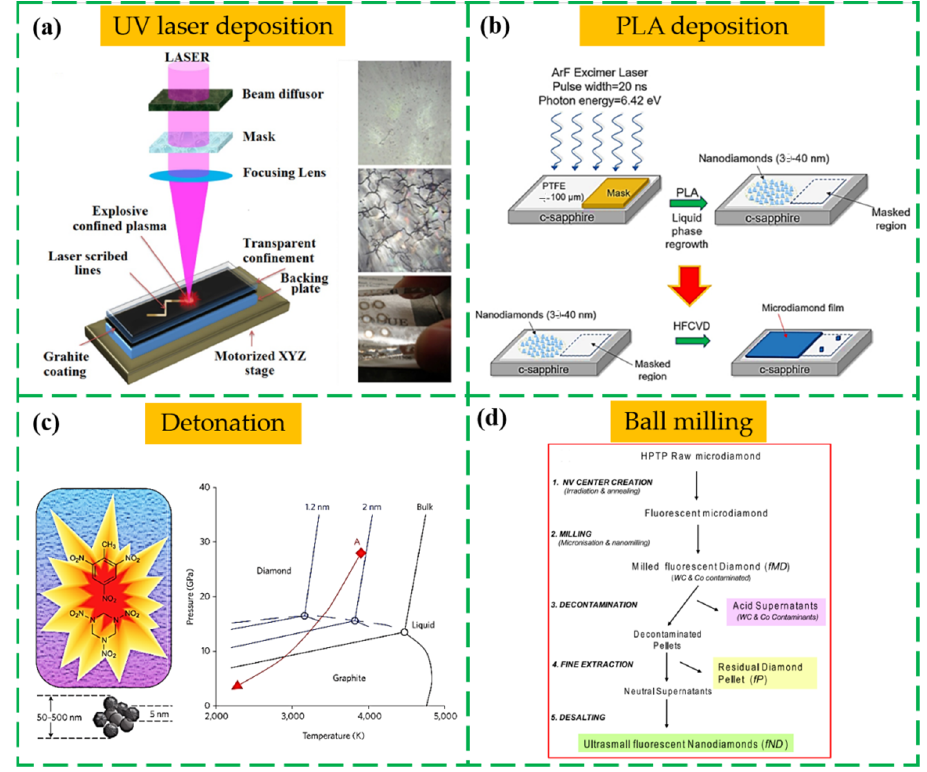
Figure 2. The commercially methods of the ND particles used in seeding process. The experimental schematic process of ( a ) the UV laser deposition [27], ( b ) PLA deposition [50], ( c ) detonation [51], and ( d ) ball milling technique [53].